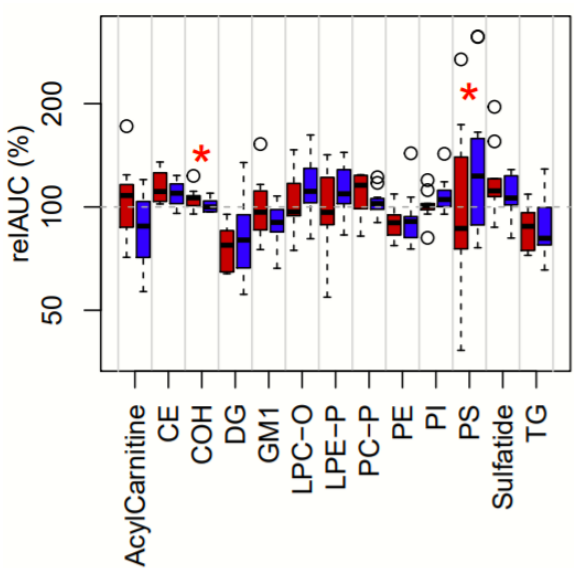
Figure 3. Relative AUCs following KO and FO supplementations for 13 lipid classes of interest. Thirteen lipid classes had at least one nominally significant change following at least one supplementation. Relative area under the curve (relAUC) is an estimate of the total plasma lipid flux over the 30-day period. Boxplots show the distributions of relAUC percentages across all 11 participants after KO (red) and FO (blue) supplementation. Asterisks (*) denote lipid classes with nominally significant (unadjusted p < 0.05) differences between treatments. Circles represent outlier values (outside of 1.5 times the interquartile range). Abbreviations: CE, cholesteryl ester; COH, cholesterol; DG, diacylglycerol; GM1, GM1 ganglioside; LPC-O, lysoalkylphosphatidylcholine; LPE-P, lysoalkenylphosphatidyethanolamine; PC-P, alkenylphosphatidylcholine; PE, phosphatidylethanolamine; PI, phosphatidylinositol; PS, phosphatidylserine; TG, triacylglycerol.